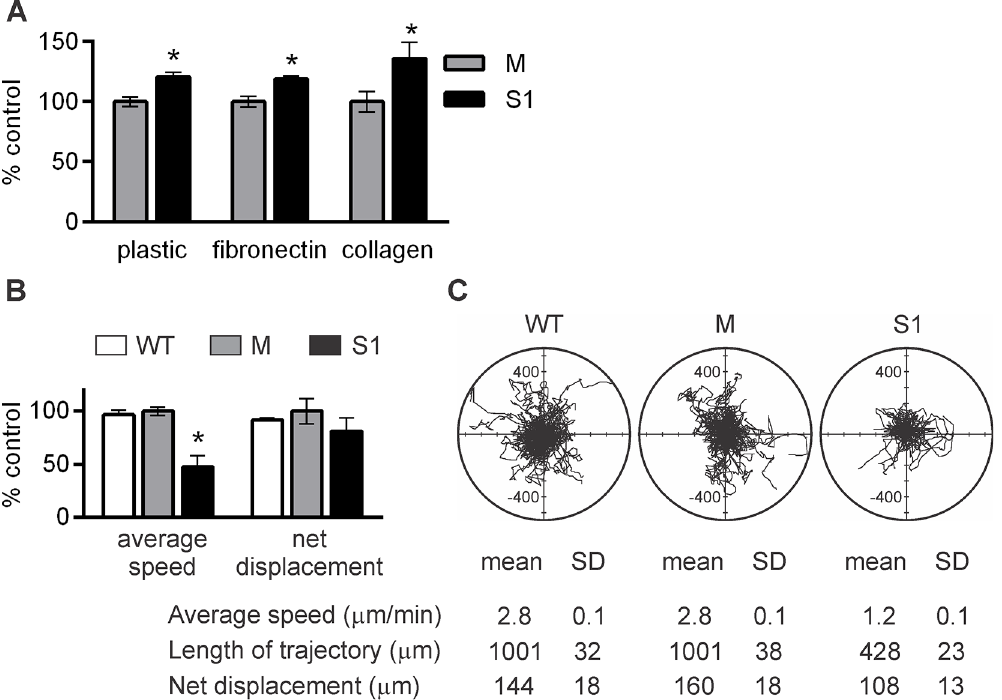
Fig 3. ADAM17 silencing increases adhesion and decreases migration of lymphatic endothelial cells (LEC). ( A ) Adhesion of M and S1 to different substrates assessed by alamarBlue assay. Fluorescence intensity of M that adhered to each substrate was taken as 100%. Bars represent mean ± SD from at least three independent experiments performed in triplicates. * P < 0.05 vs M. ( B ) Analysis of single cell motility. Bars represent average values of speed and net displacement of migrating WT, M and S1 from three (M and S1) or two (WT) independent experiments. In each experiment, movements of 60 cells per group were analyzed and normalized to the average values obtained for M. * P < 0.01 vs M. ( C ) Exemplary trajectories of migrating WT, M and S1 displayed in circular diagrams drawn with the initial point of each trajectory placed at the origin of the plot. Each panel shows the trajectories of 60 cells. The characteristics of cell movement from the representative experiment are presented below the